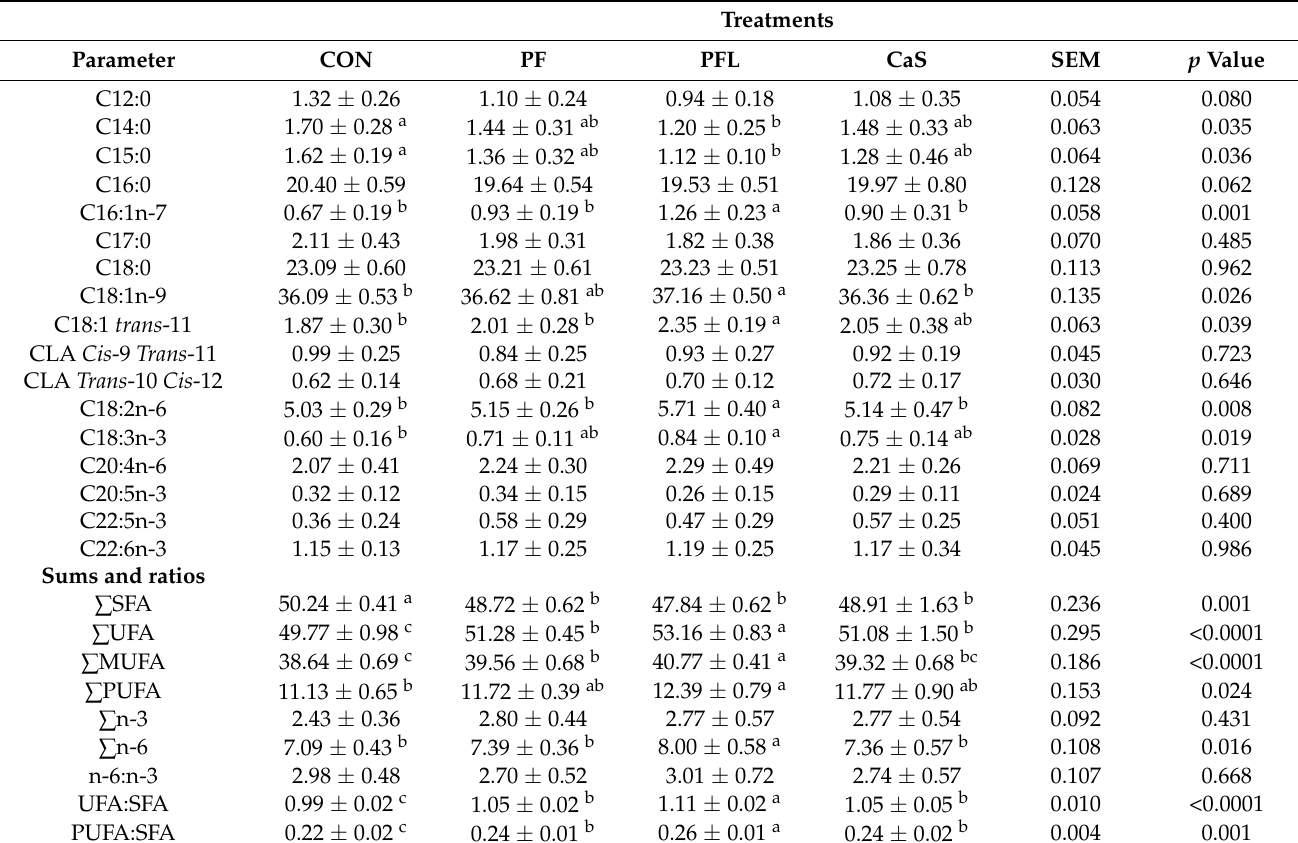
Table 5. The fatty acid composition of longissimus dorsi muscle in Dorper sheep.